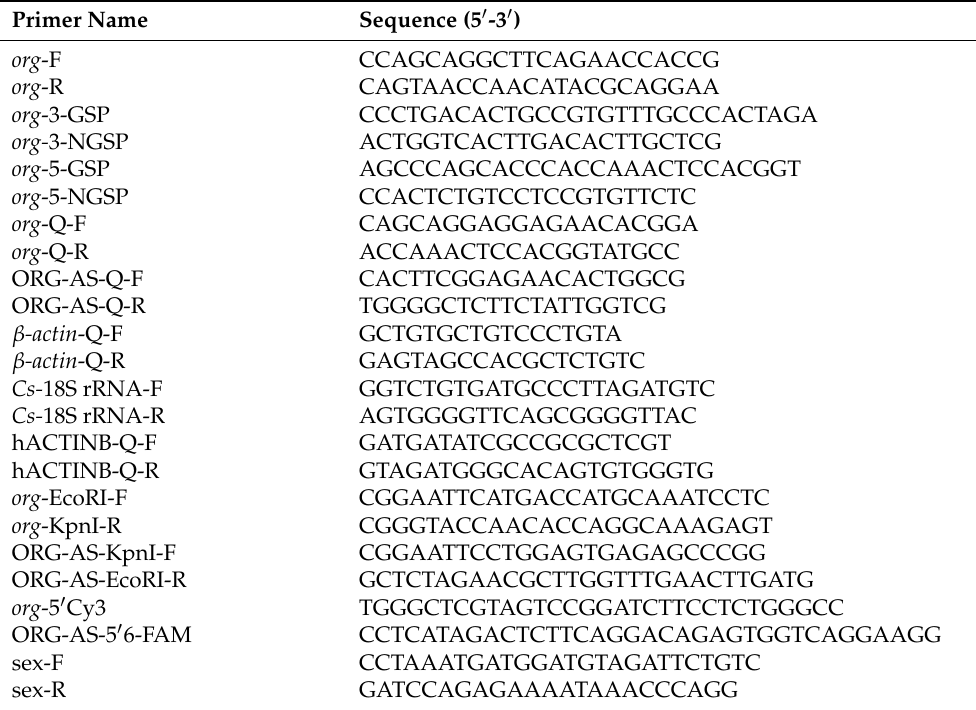
Table 1. Primers used for cloning and gene expression